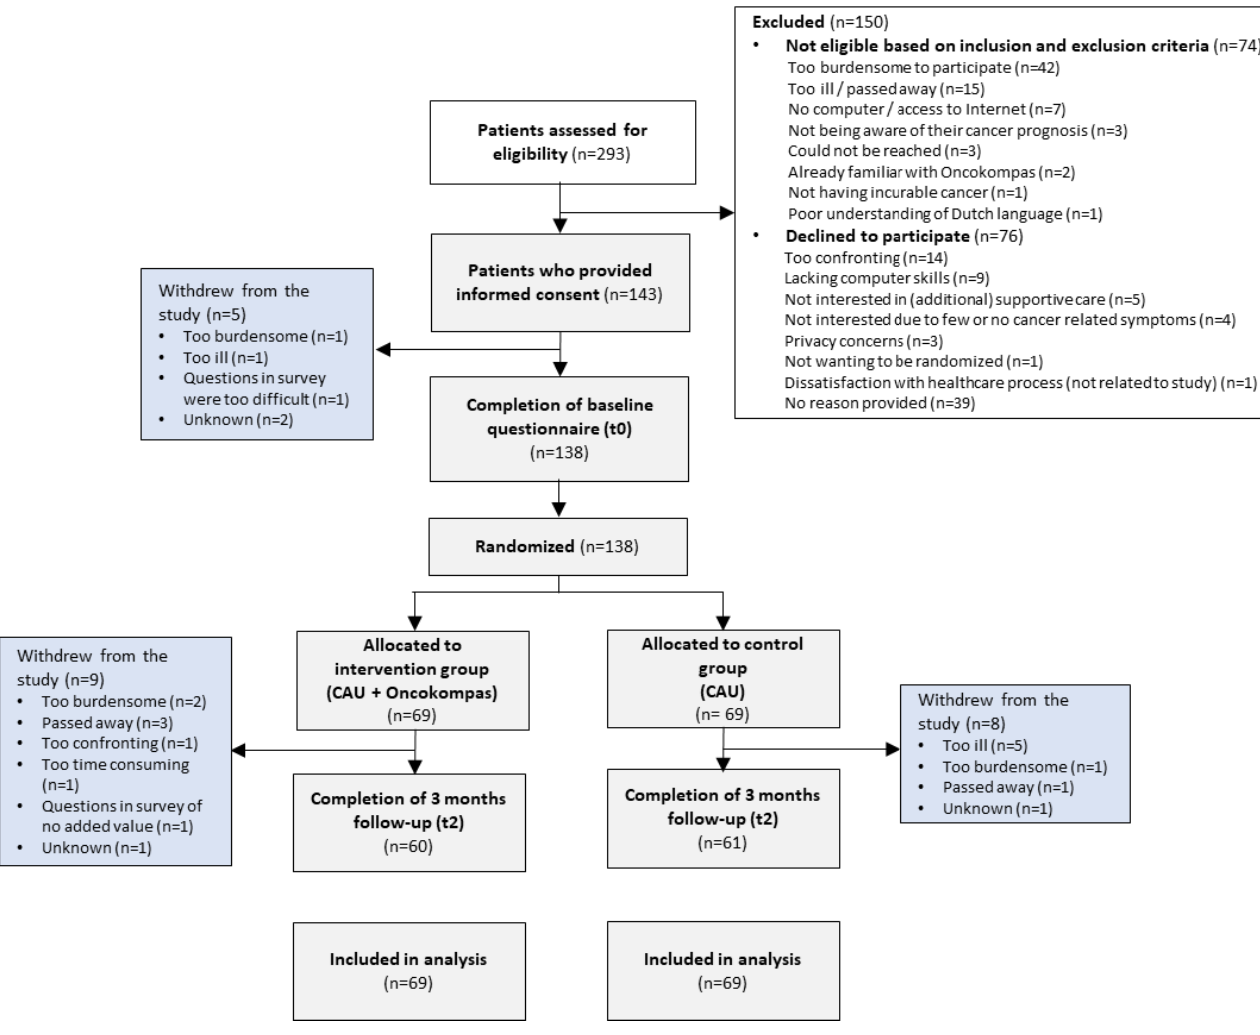
Figure 1. Flow diagram of the study. Table 1. Patients’ sociodemographic and clinical characteristics at baseline.